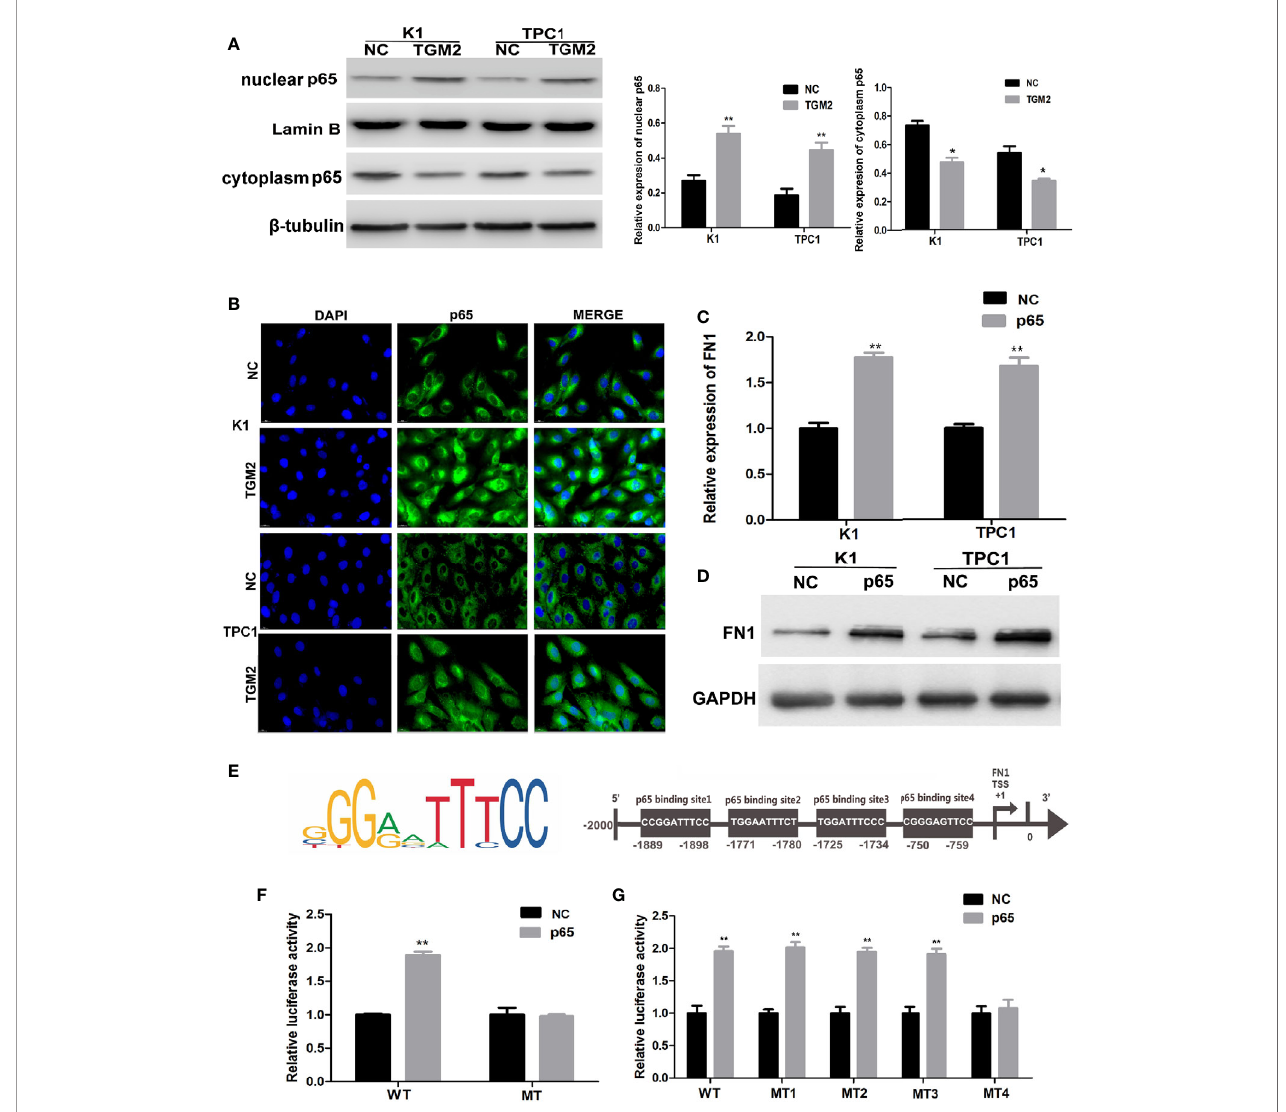
FIGURE 7 | TGM2 transcriptionally activates FN1 by promoting p65 nuclear translocation in PTC cell lines. (A) Overexpression of TGM2 activates p65 nuclear translocation in PTC cells, as measured using western blot assays. Data are presented as the mean ± S.D., as analyzed using an independent samples t-test. *P < 0.05; **P < 0.01 versus NC. (B) Overexpression of TGM2 activates p65 nuclear translocation in PTC, as measured using immuno fl uorescence staining. (C) qRT-PCR was applied to detect the protein level of FN1 in PTC cells transfected with p65 or NC. Data are presented as the mean ± S.D., as analyzed using an independent samples t-test. **P < 0.01 versus NC. (D) Western blotting was applied to detect the protein level of FN1 in PTC cells transfected with p65 or NC. Data are presented as the mean ± S.D., as analyzed using an independent samples t-test. **P < 0.01 versus NC. (E) Prediction of the p65 binding site in the FN1 promoter region using JASPAR (http://jaspar.genereg.net/). (F) The effect of overexpression of p65 on luciferase activity of a vector containing the FN1 wild-type promoter or mutated promoter. Data are presented as the mean ± S.D., as analyzed using an independent samples t-test. **P < 0.01 versus NC. (G) The effect of p65 overexpression on the luciferase activity of a vector containing the FN1 wild − type promoter or mutation site 1, mutation site 2, mutation site 3, or mutation site 4. Data are presented as the mean ± S.D., as analyzed using an independent samples t-test. **P < 0.01 versus